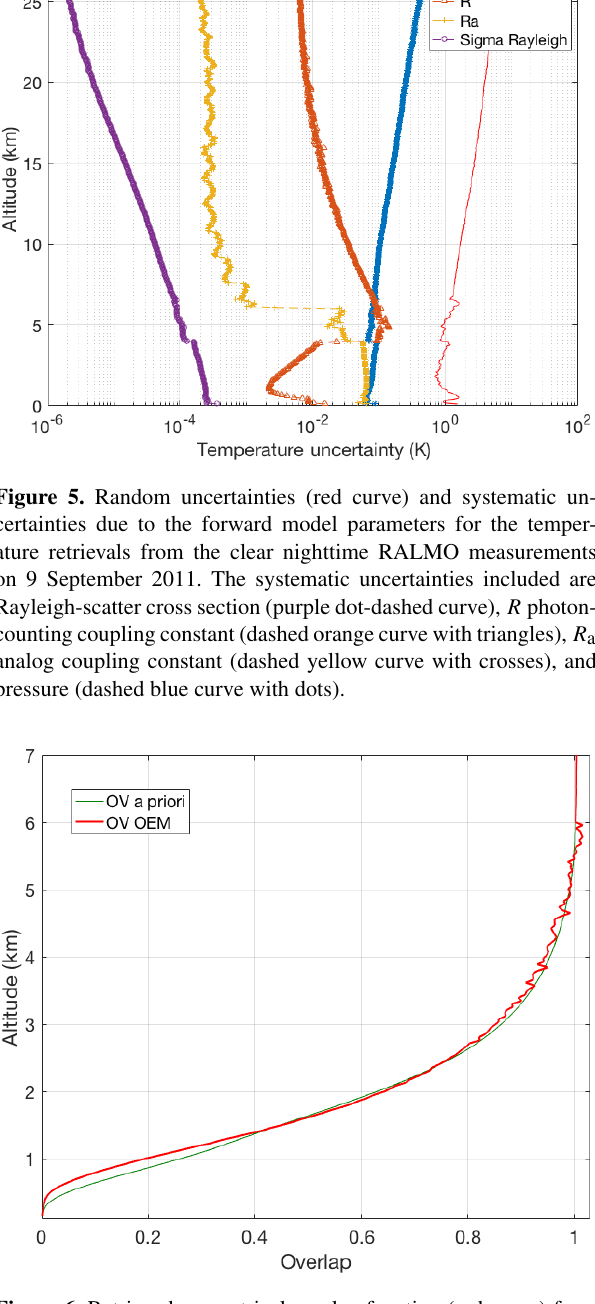
Figure 6. Retrieved geometrical overlap function (red curve) from the clear nighttime RALMO measurements on 9 September 2011 compared to the a priori geometrical overlap function (green curve).